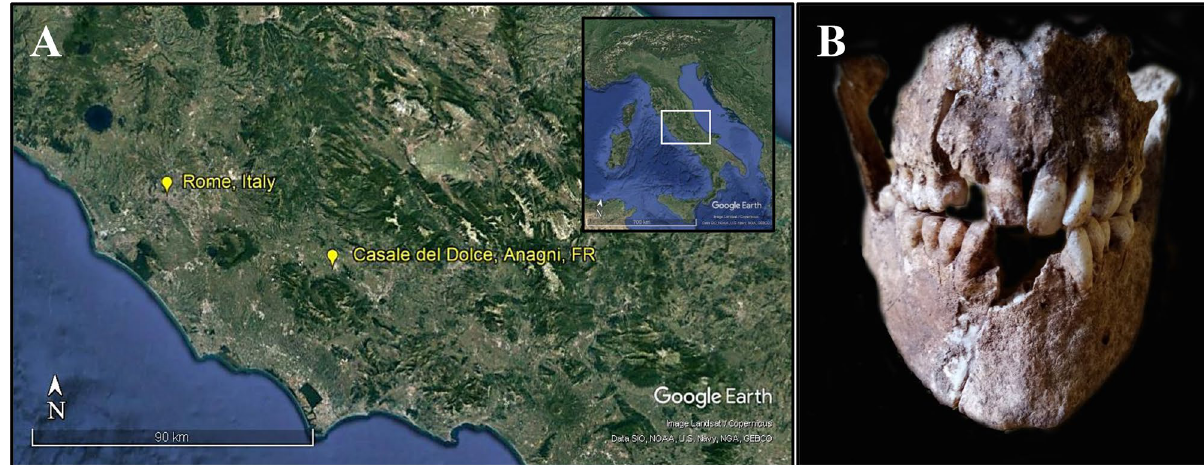
Figure 1. Archaeological site and masticatory apparatus of CDD7. Location of Casale del Dolce archaeological site ( A ): images produced using Google Earth Pro, V 7.3.3.7786 (June 25, 2019) Casale del Dolce (Latium,